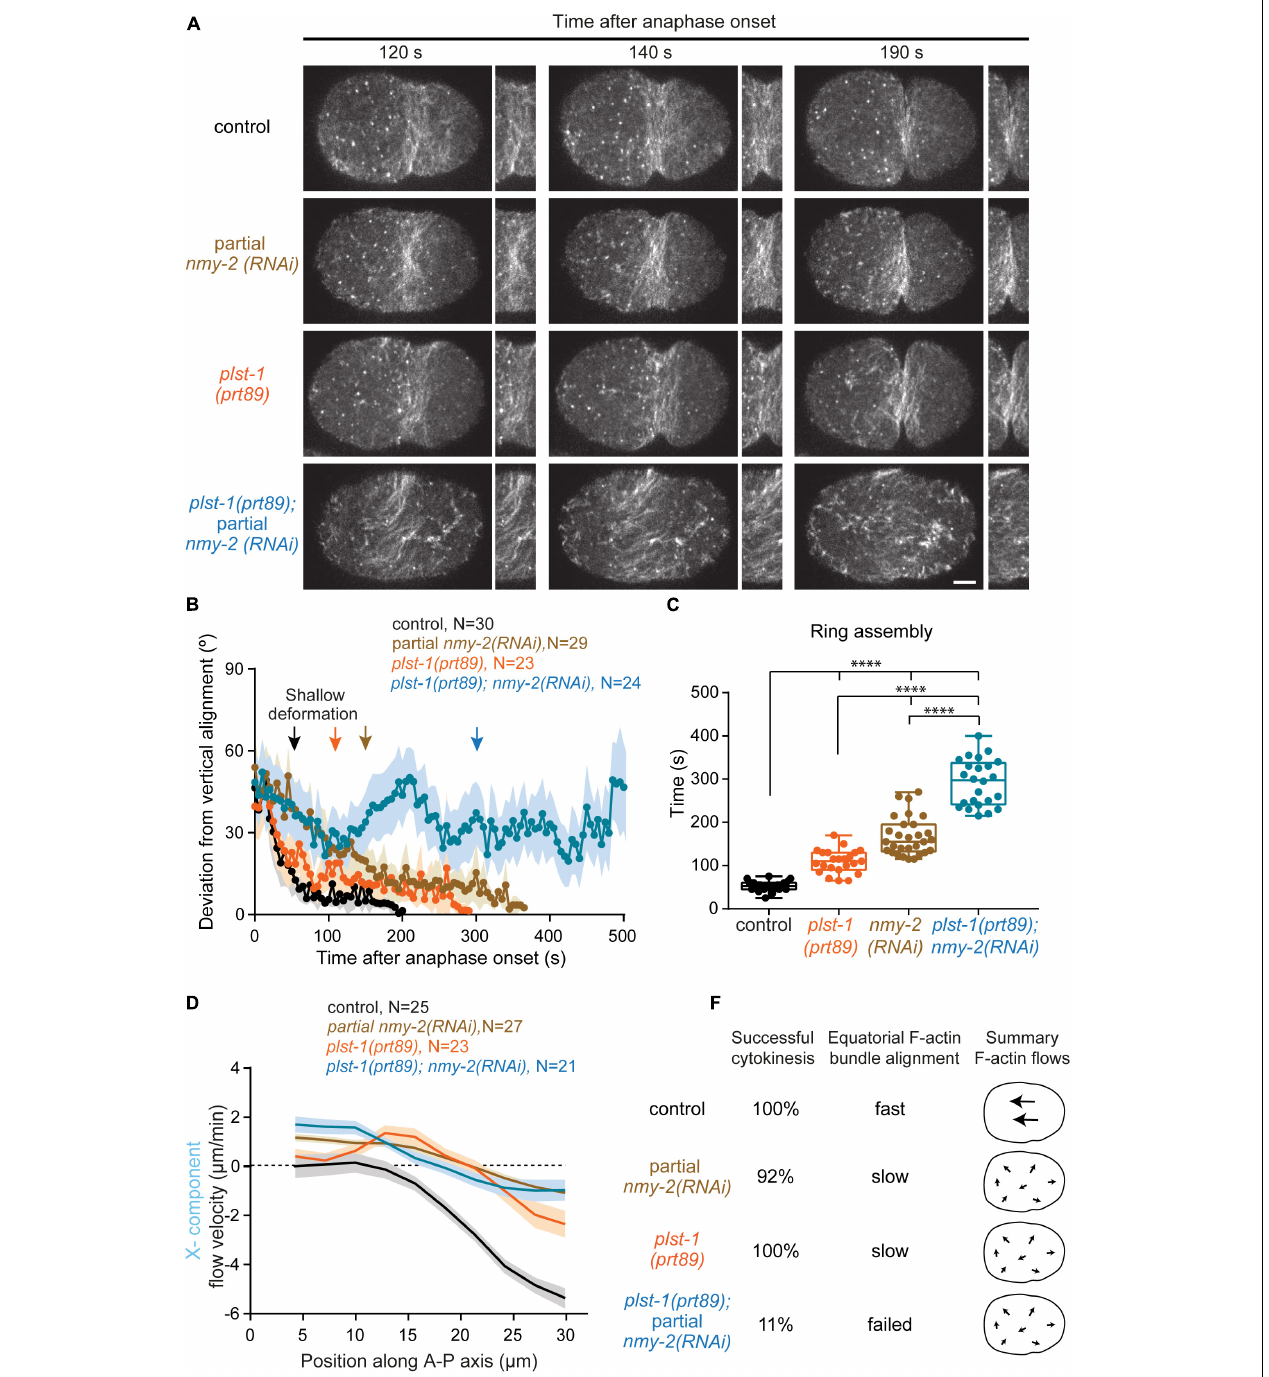
FIGURE 4 | The F-actin crosslinker plastin cooperates with myosin to align F-actin bundles at the division plane. (A) Images of the cortical plane of embryos expressing LifeAct::GFP showing the evolution of the equatorial F-actin band relative to anaphase onset. Also see Supplementary Movie S1 . (B) Deviation from vertical alignment of F-actin bundles at the equatorial cortex relative to anaphase onset (mean ± SEM). (C) Boxplots showing the dispersion of contractile ring assembly times. In each box, the central line is the median, the boundaries of the box are the 25th and 75th percentiles; the whiskers extend to include the maximum and minimum values. (D) Longitudinal (X-component) velocity profiles of Lifeact::GFP cortical flows along anterior-posterior (A-P) axis averaged for a period of 50 seconds starting at shallow deformation. Flow profiles show mean X-component velocity ± SEM. (E) Values on the left indicate percentage of embryos that completed cytokinesis successfully. On the right, a summary of F-actin bundle alignment at the equator and overall flow intensity and directionality (X-component). N is the number of embryos analyzed. Statistical significance of ring assembly times in (C) was determined using one-way ANOVA followed by Bonferroni’s multiple comparison test. ∗∗∗∗ P < 0.0001. Scale bar, 5 µ m.